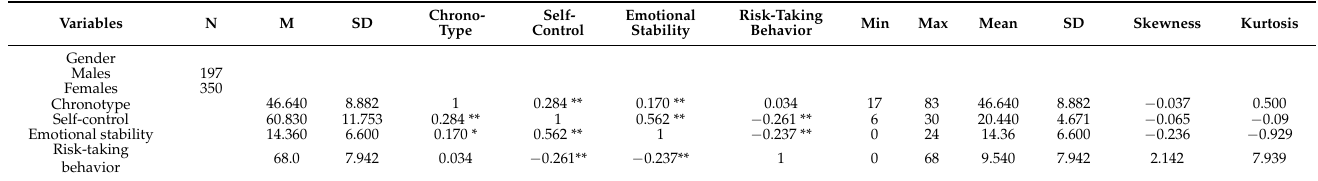
Table 1. Descriptive statistics of the sample and correlations of all variables.